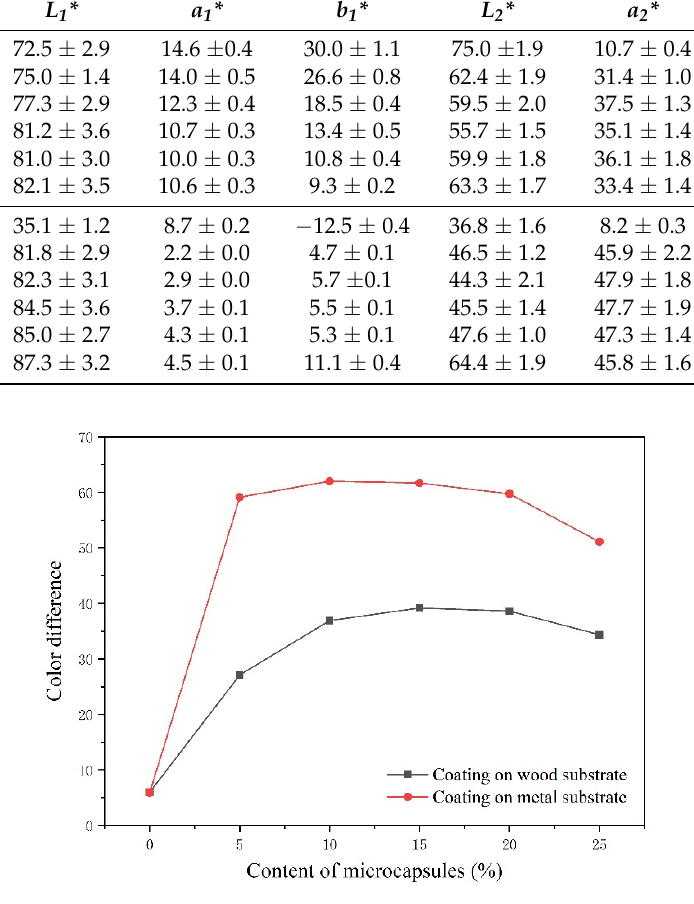
Figure 7. Color difference of the coatings.